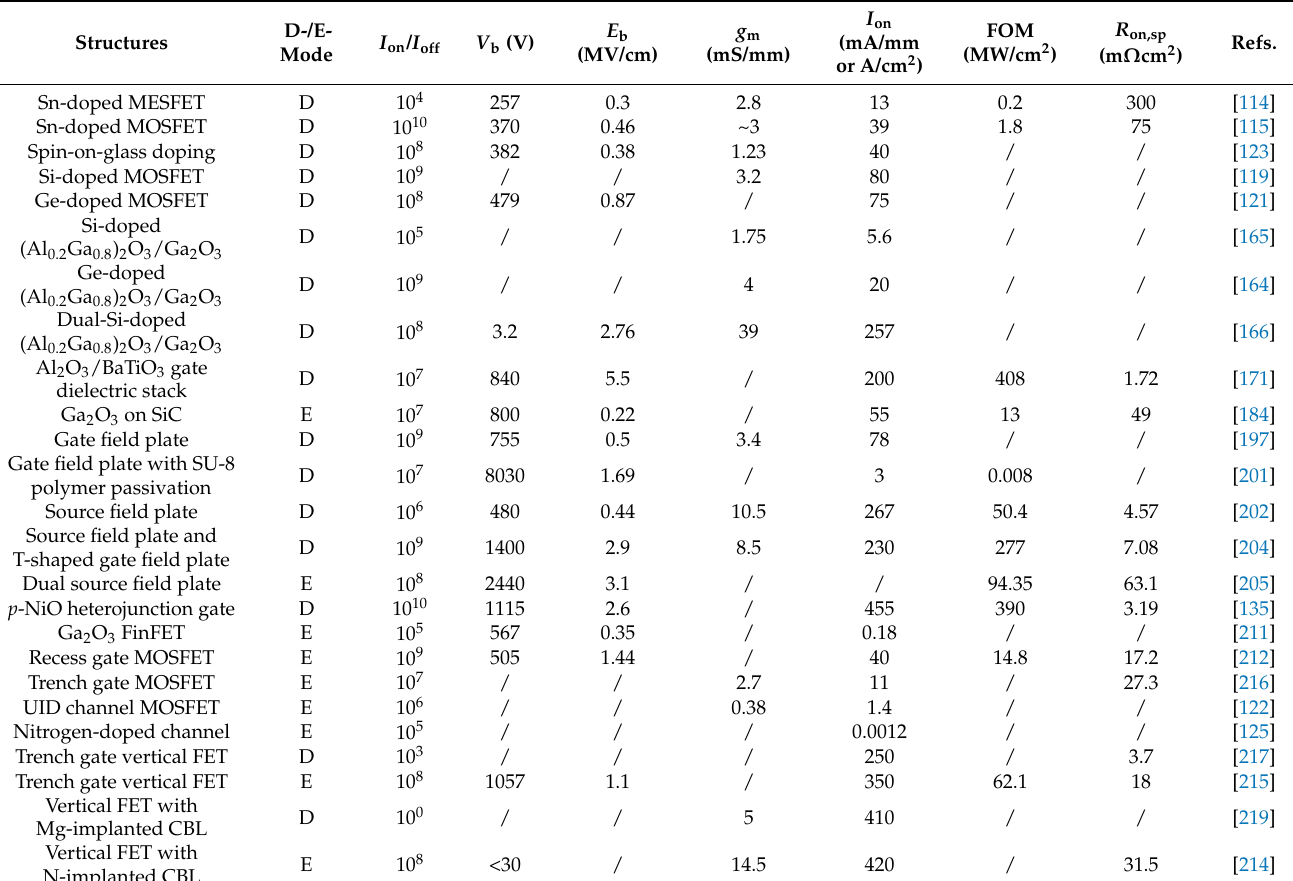
Table 3. Comparison of electric performances for β -Ga 2 O 3